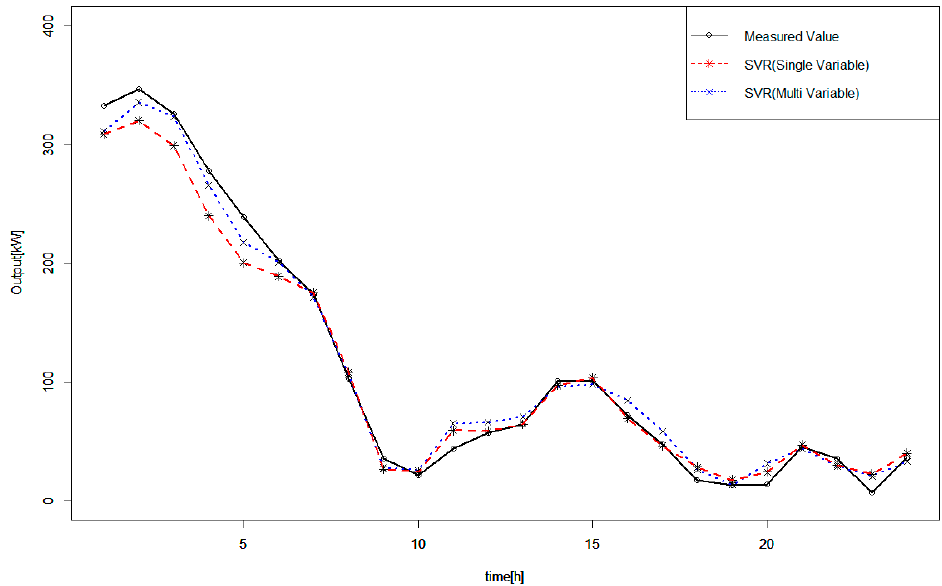
Figure A2. Measured and forecasted wind power outputs to additional turbine on 8 January 2016. Table A5 shows the accuracy of forecasted values. Table A5. Accuracy of SVR model and Persistence method (8 January 2016).